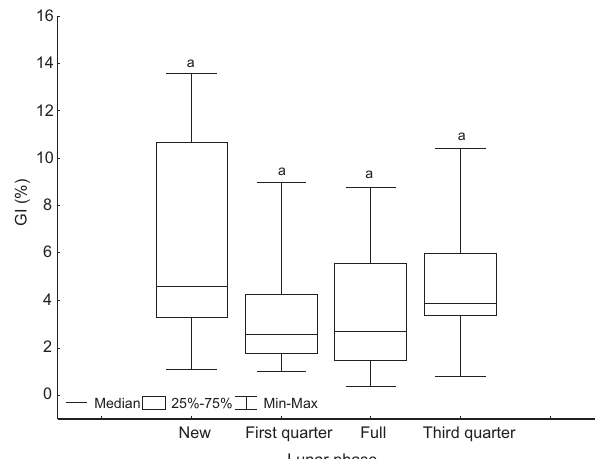
Figure 5. Variation in the gonad index (GI) of Echinaster ( Othilia ) guyanensis collected in southeastern Brazil (n = 20 specimens per phase) according to the moon phase. Letters designate statistical differences (different letters) as indicated in the non-parametric Tukey test (p < 0.05).